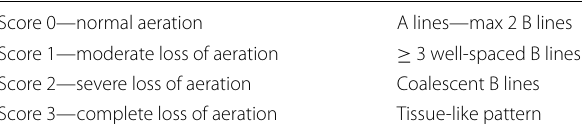
figure on next Fig. 1 High-flow nasal oxygen therapy algorithm. *1: Thoraco-abdominal asynchrony and/or persistent auxiliary muscle use. *2: The table shows escalation and de-escalation of oxygen in the HFNO 2 group (Table 2). *3: Respiratory rate <25 breath/min or SpO 2 breathing. ABG, no respiratory acidosis (PH>7.35), no CO 2 rise for > or therapy; NIPPV, non-invasive positive pressure ventilation; IPPV, invasive positive pressure ventilation; SpO 2 , oxygen